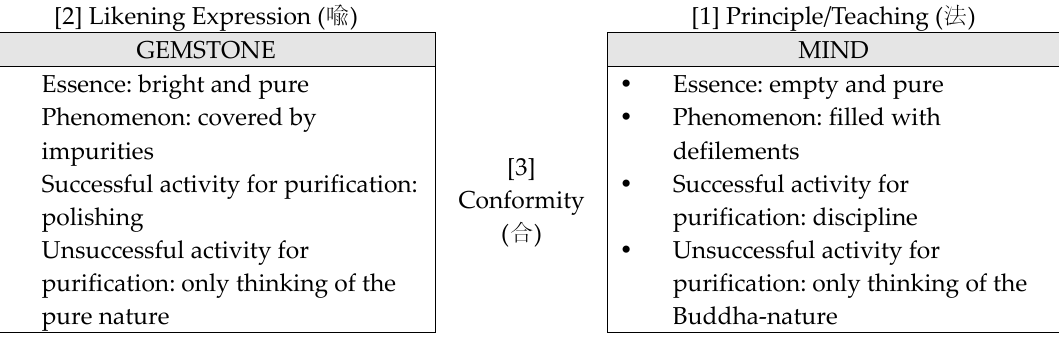
Figure 2. A typical structure of analogical figuration in the form of principle, likening expression, and conformity.